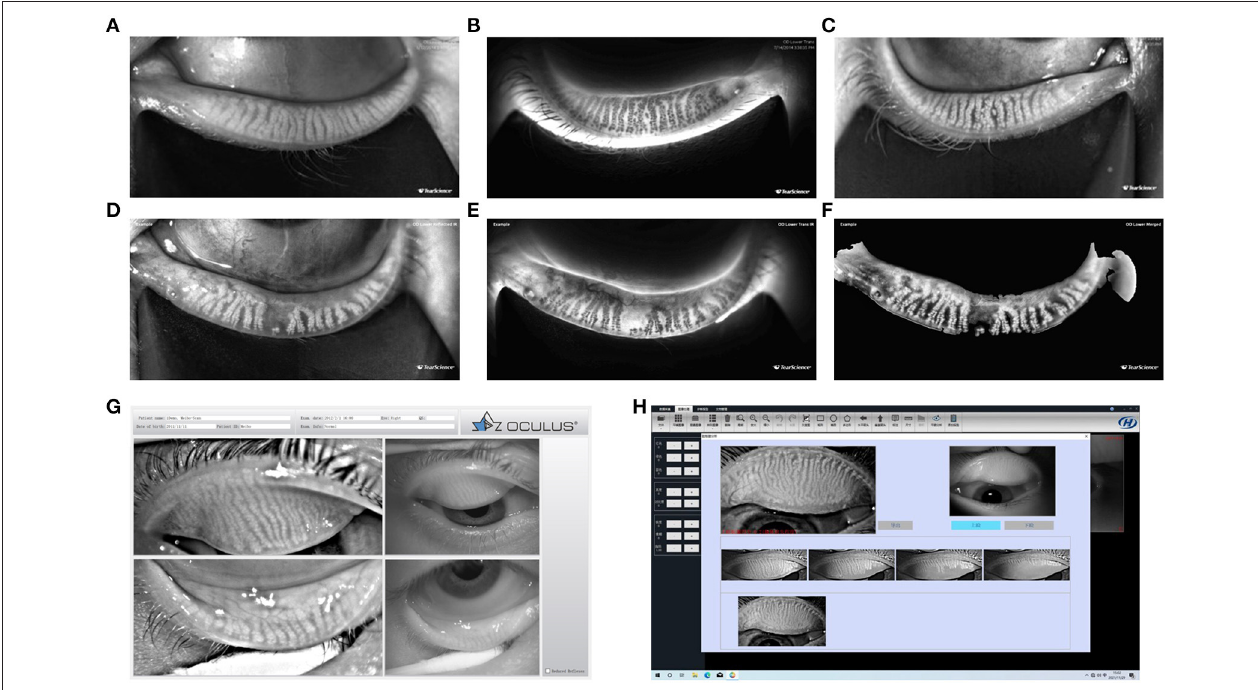
FIGURE 5 | Meibomian gland morphology. Ocular surface interferometer—LipiView II interferometer (A–C) ; Dynamic Meibomian Imager—LipiScan (D–F) ; OCULUS Keratograph 5M (G) ; Kanghua Dry Eye Analyzer (H) . Examples for LipiView II and LipiScan: The images of the glands may be viewed on the computer screen display and in a printed report. Three modes of gland images are provided: Reflected infrared view is shown for both upper and lower eyelid gland images. (A,D) Show only lower eyelid gland images. Transillumination infrared view is shown only for lower eyelid gland images, if images were captured using handheld near-infrared lid everter (B,E) . Merged view is the combination of the reflected infrared and trans infrared views and is shown only for the lower eyelid gland images (C,F)